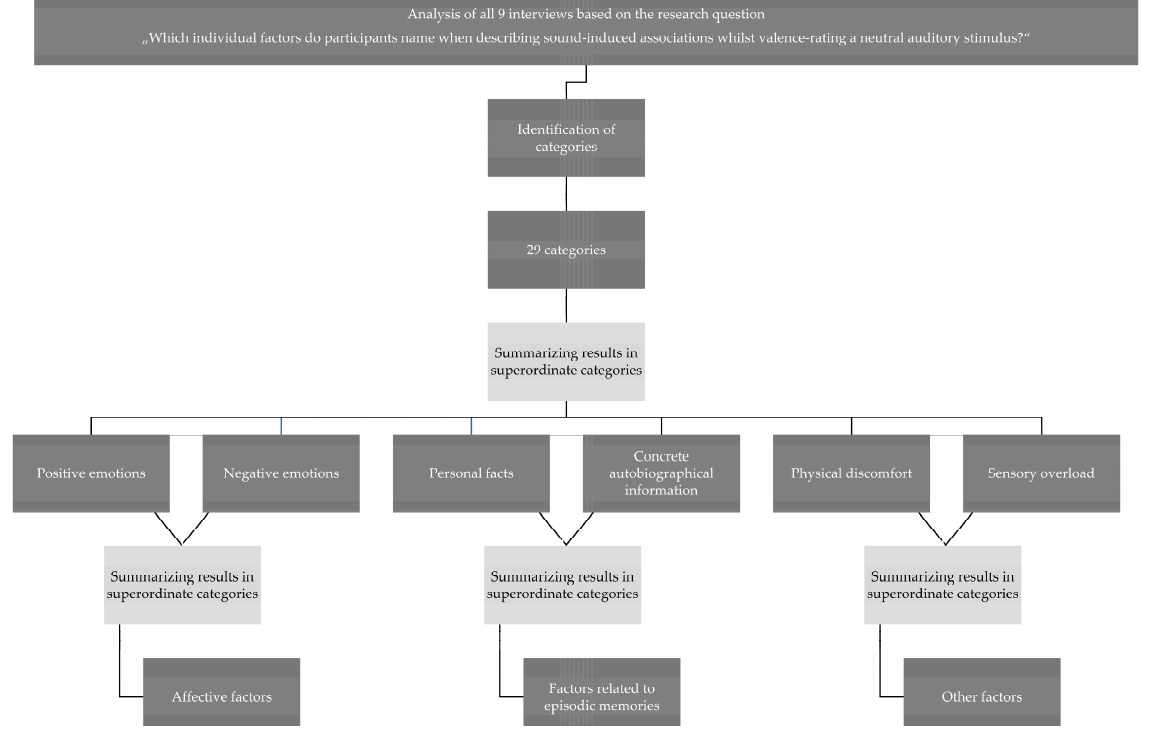
Figure 1. Data analysis process based on Mayring’s systematic method of qualitative content analysis.